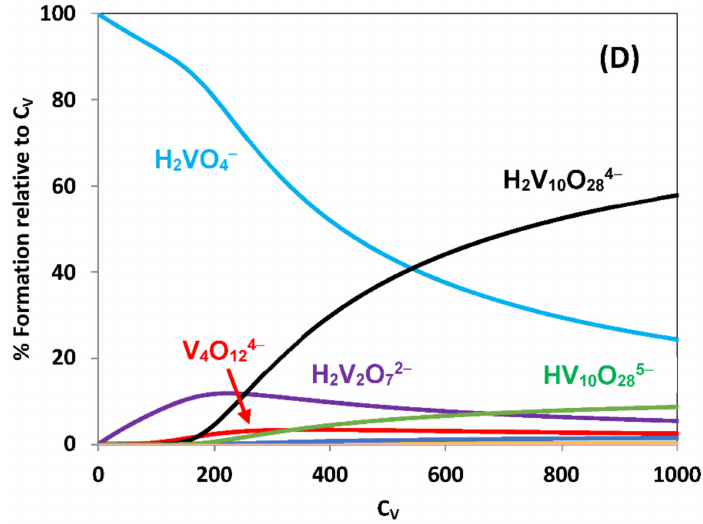
Figure 2. Species distribution diagrams, calculated with the computer program HySS [33], of V V hydrolysis: ( A ) at C V = 1 × 10 − 3 M, ( B ) at C V = 1 × 10 − 5 M, in the pH range 3–11; at pH = 7 ( C ) and pH = 5 ( D ) with the total vanadium(V) concentration varying in the range 1 to 1000 µ M. The formation constants of the hydrolytic V V -species were taken from